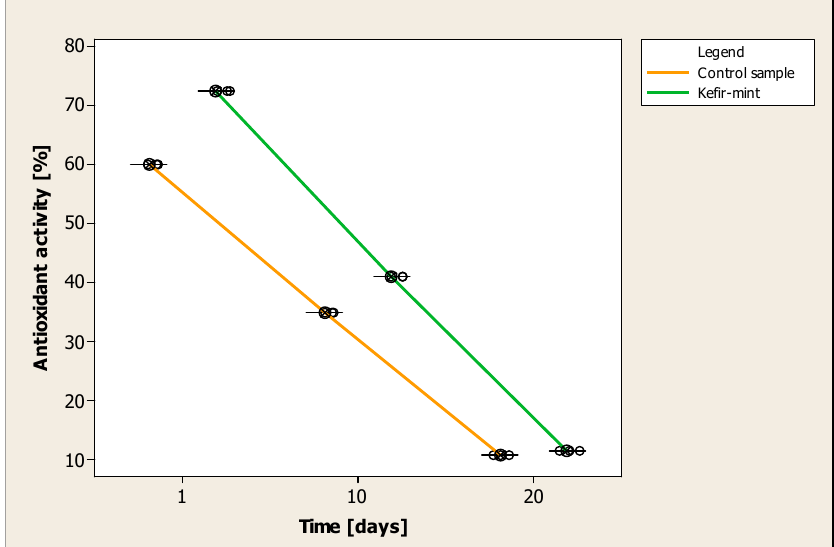
Figure 4. Comparative variation of antioxidant activity in kefir sample enriched with encapsulated mint volatile oil and control sample.